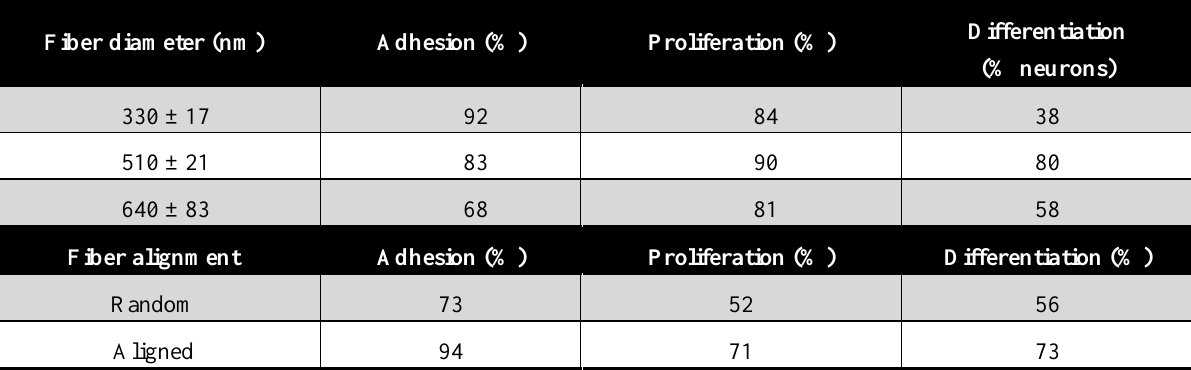
Table 1. The influence of fiber diameter and alignment on adhesion, proliferation, and differentiation. Cell counts were performed three days after seeding cells on the scaffolds.